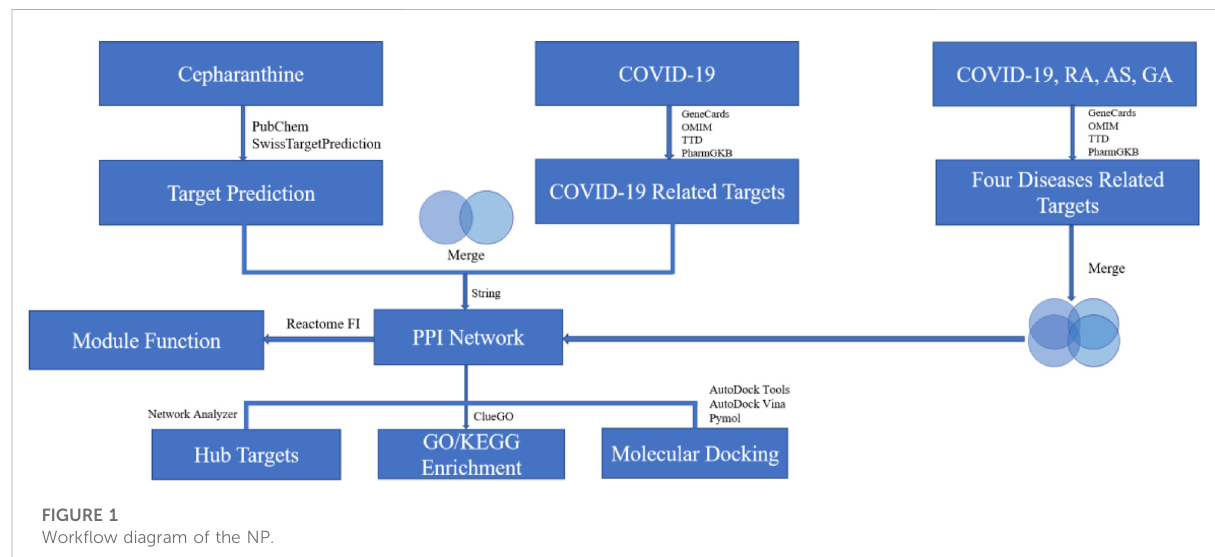
FIGURE 1 Work fl ow diagram of the